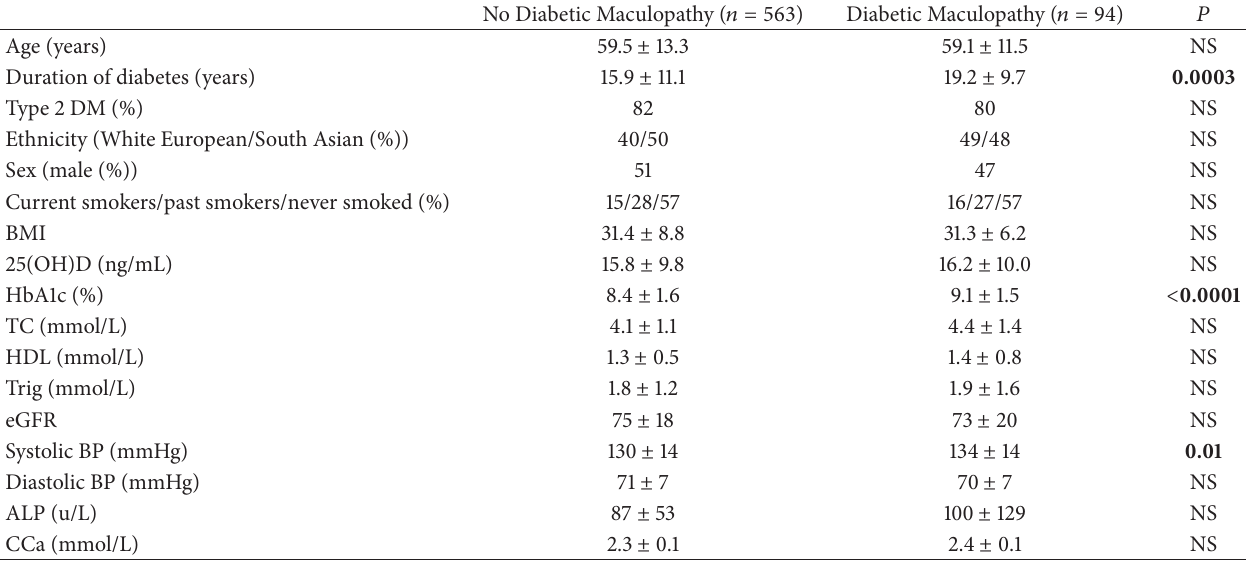
Table 3: Demographic and metabolic parameters in subgroups based on maculopathy.